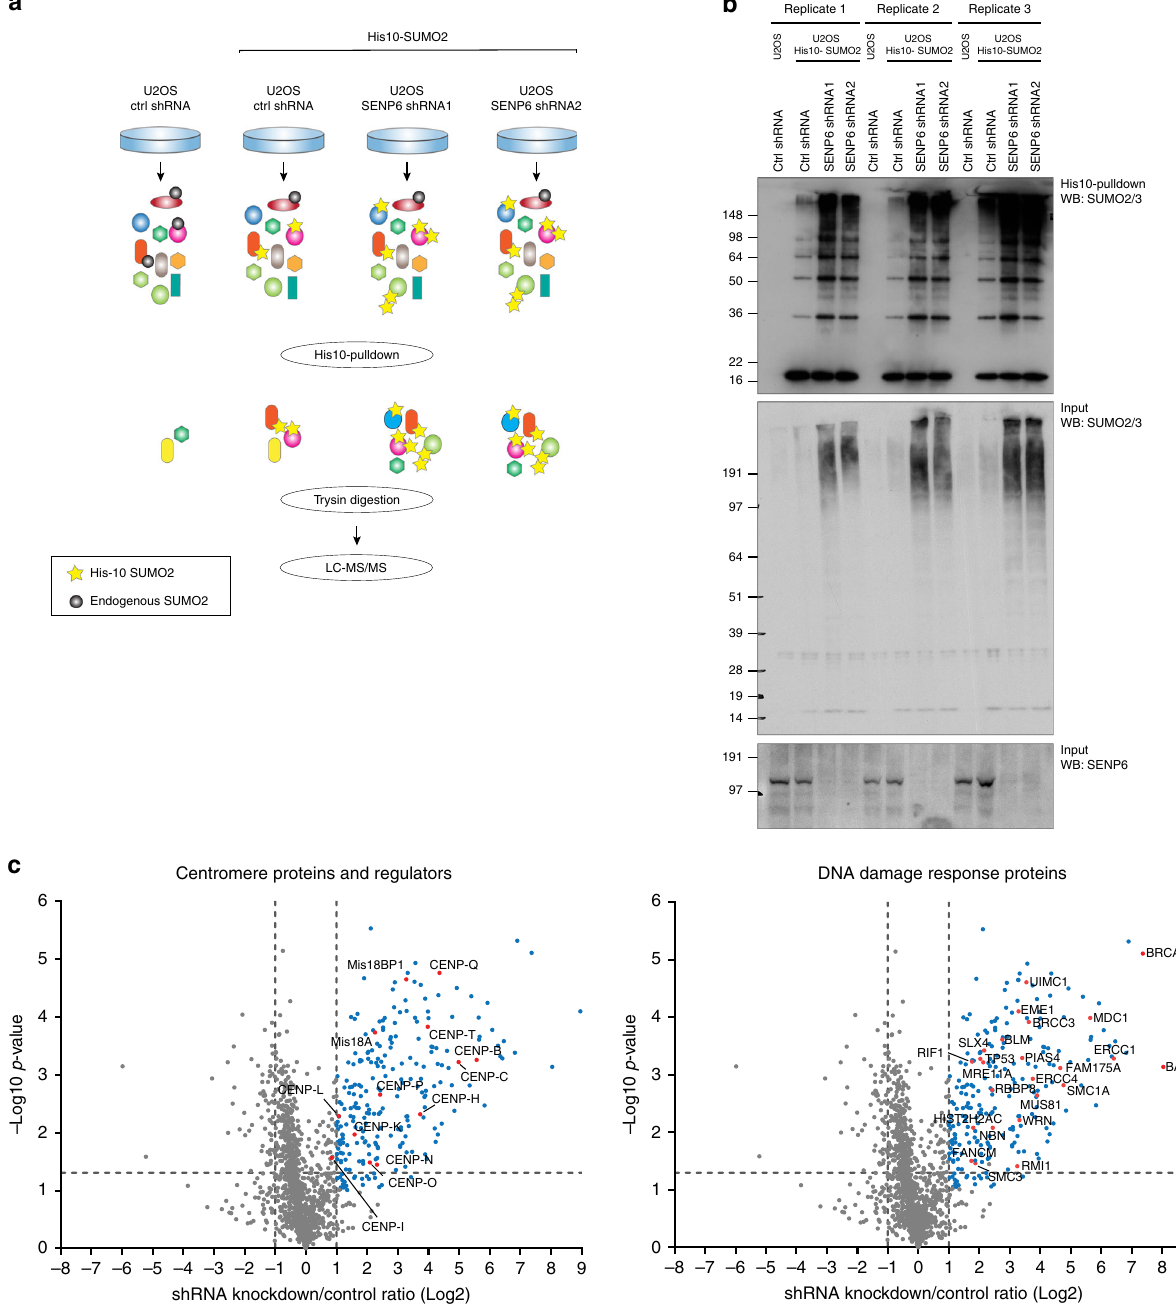
Fig. 2 Identi fi cation of target proteins regulated by SUMO polymers. a Experimental set up for the identi fi cation of SENP6-regulated proteins. U2OS cells stably expressing His10-SUMO2 were infected with lentiviruses encoding shRNAs targeting SENP6 or a nontargeting control (ctrl) shRNA. Cells were lysed 3 days post infection and SUMOylated proteins were enriched by means of Ni-NTA pulldown. Enriched SUMOylated proteins were trypsin digested and